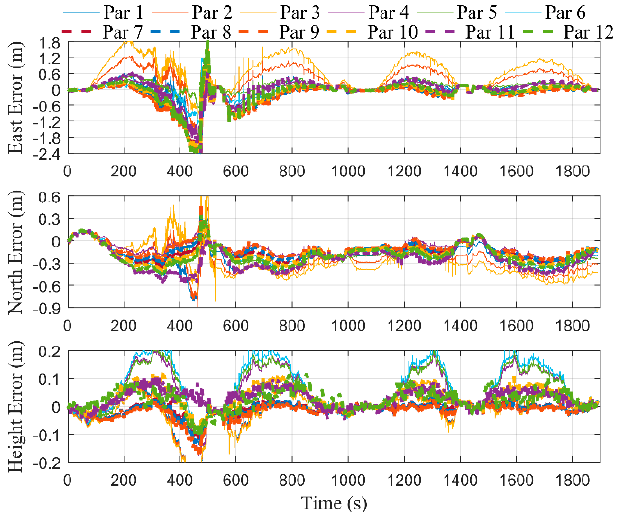
Figure 15. Positioning errors with performing RTS smoothing under different error parameters.